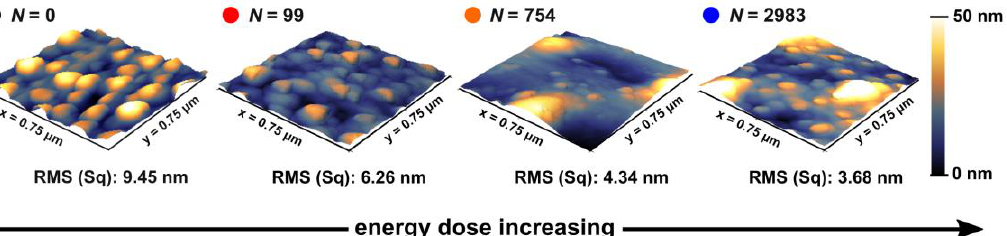
Figure 6. AFM measurements of gold-coated Si-wafer, irradiated with different effective pulse numbers N ( 𝜑 𝑝 = 127 mJ/cm 2 ) and subsequently heating to T = 925 °C. The RMS (Sq.) value indicates the surface roughness. For N = 2983 and N = 745 the roughness calculation was performed in the interstitial space between 2D-LIPSS. The color code for different pulse numbers corresponds to all images from Sections 3.2 and 3.3, i.e. Figures 6–9.